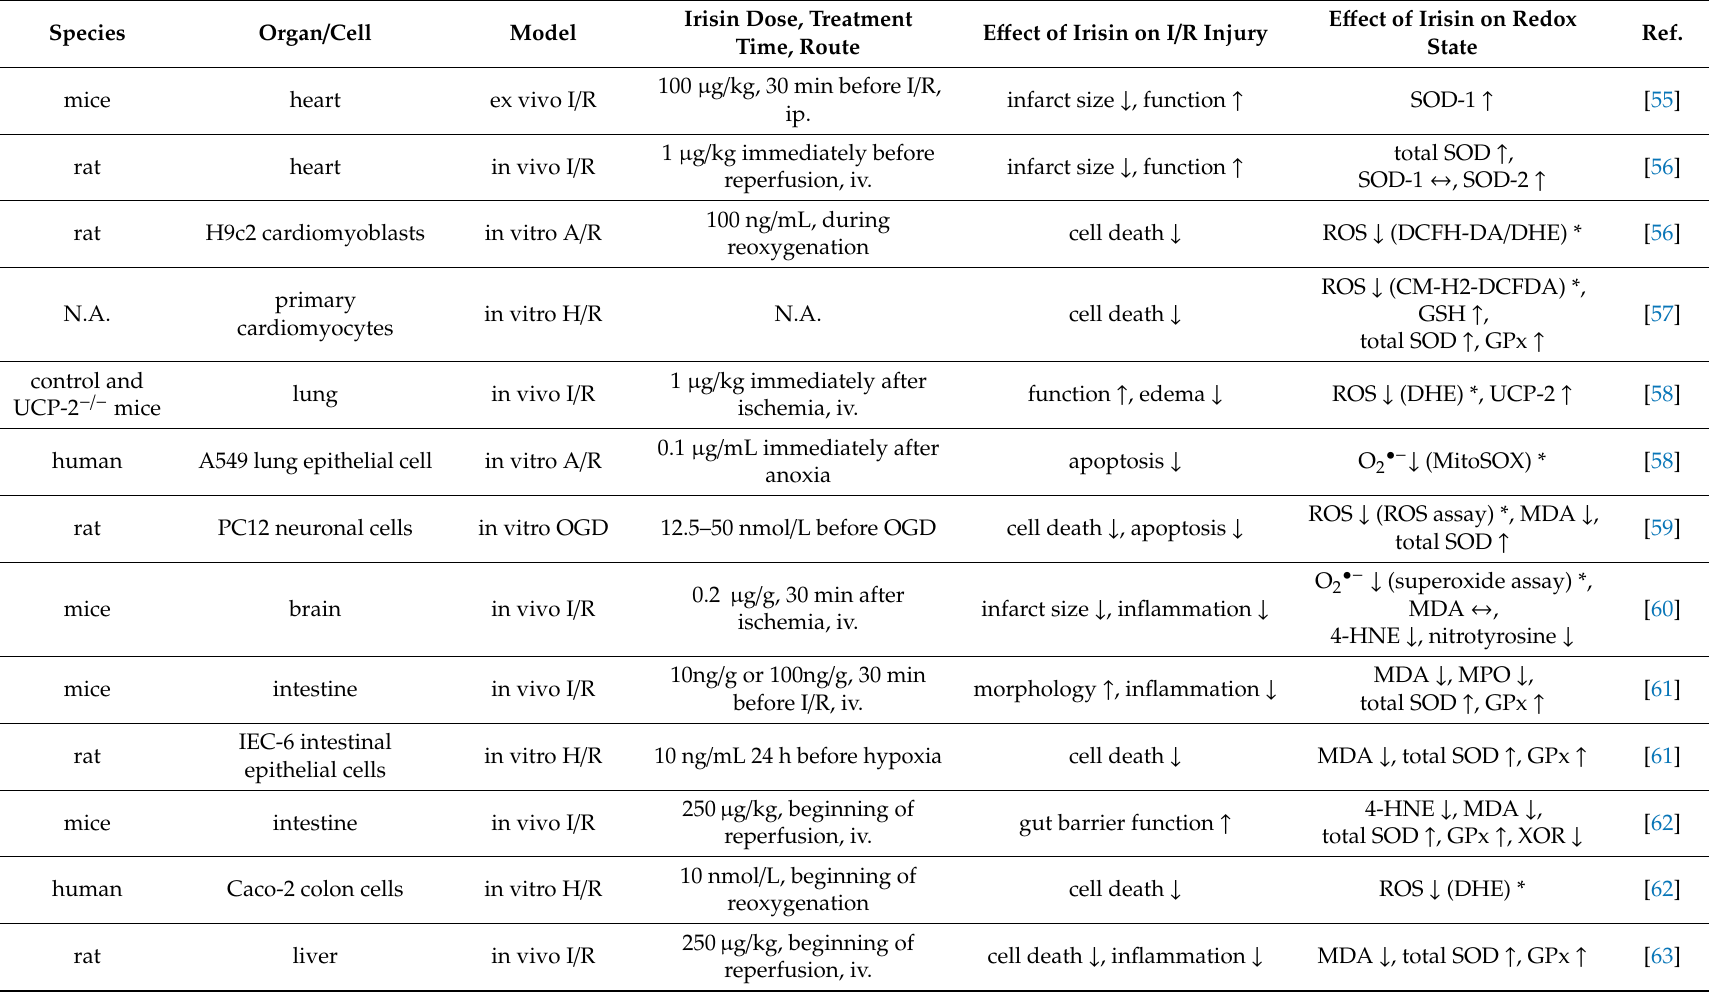
Table 3. E ff ect of Irisin on redox state in settings of I /